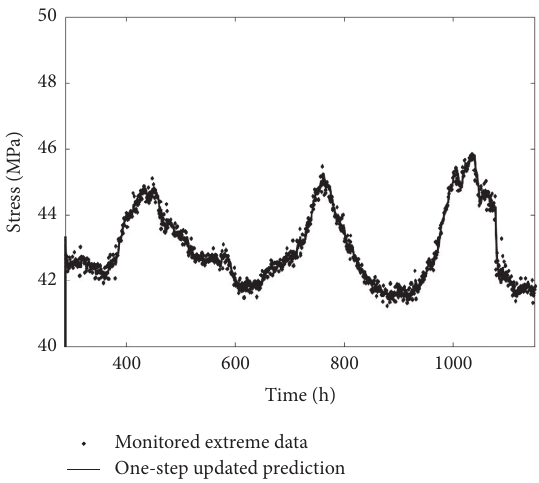
Figure 9: Monitoring stresses and one-step predicted stresses.